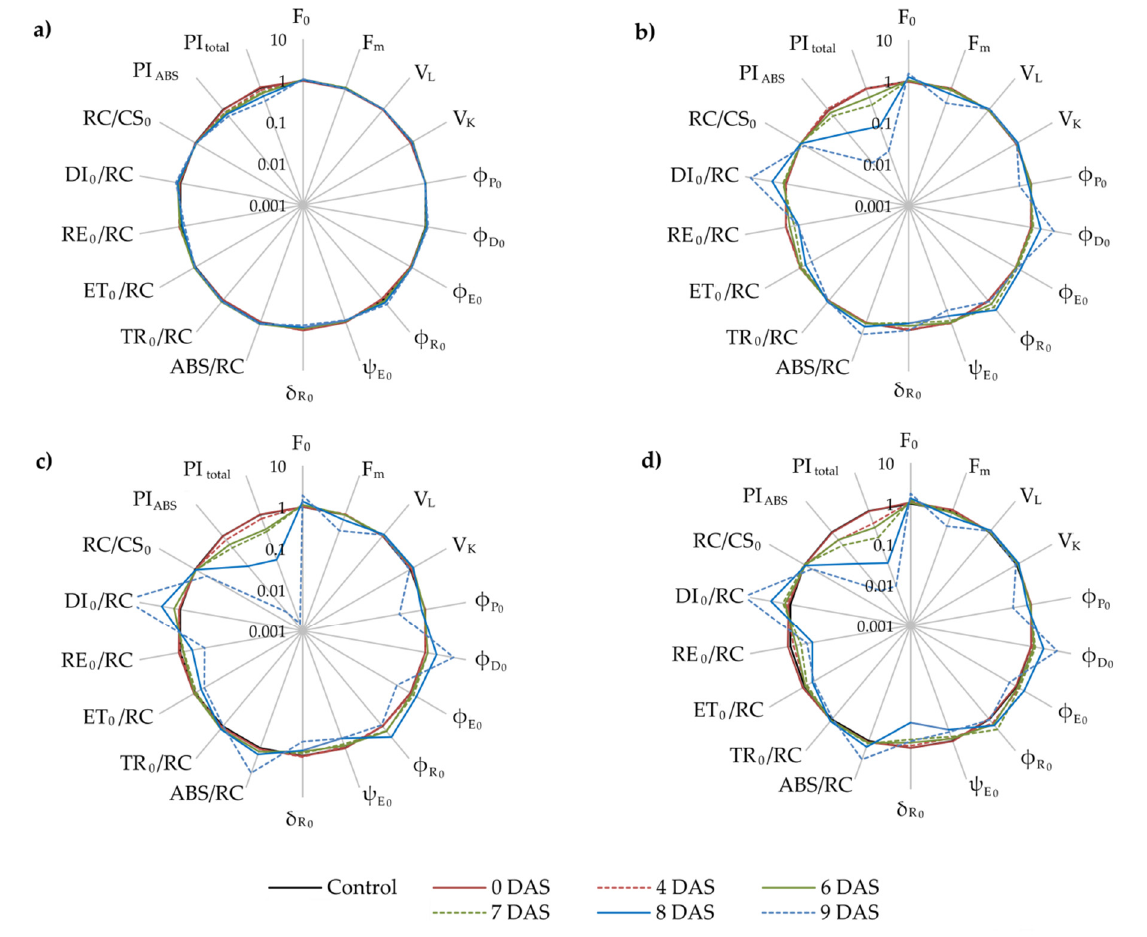
Figure 4. Radar plots (in logarithmic scale) of JIP parameters in the leaves of Obla č inska sour cherry ecotypes OS ( a ), 18 ( b ), D6 ( c ), and BOR ( d ) under control and drought conditions were obtained at 0–9 days after stress (DAS). Each data presents an average value of twenty measurements normalized and shown as a percentage of values in the control treatment, enabling the comparison of variables measured on different scales. Raw data shown in radar plots and statistical differences obtained by ANOVA followed by Fisher’s LSD test ( p < 0.5) are presented in Table S3.